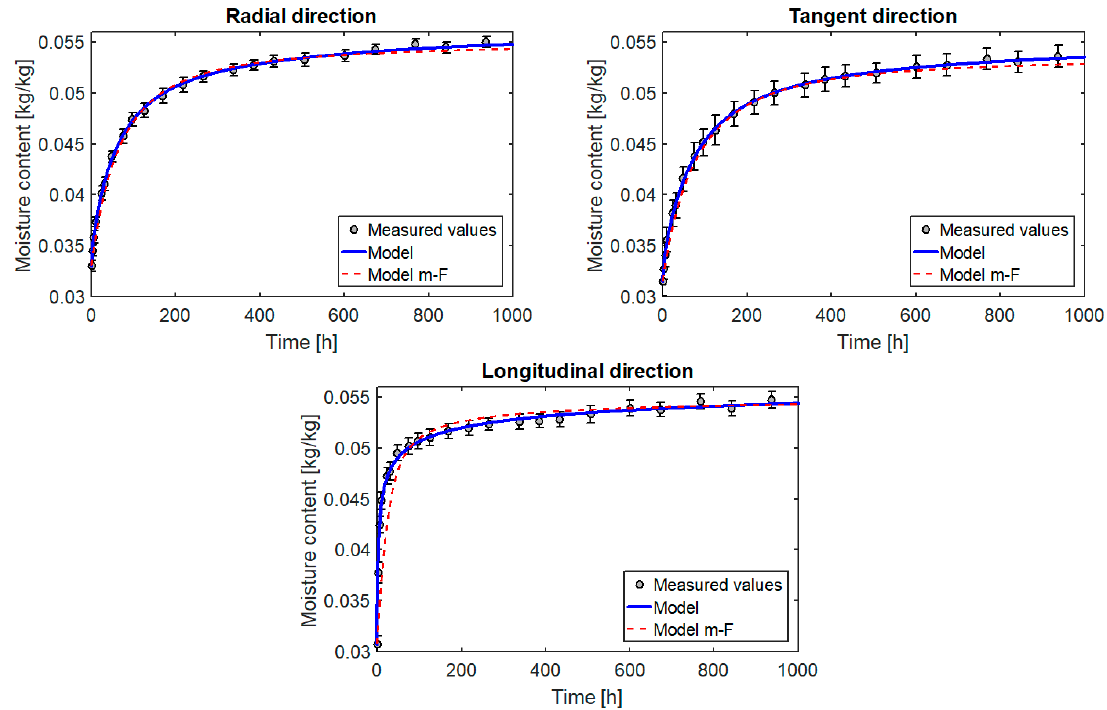
Figure 8. Changes in the moisture content of the pine samples versus time.